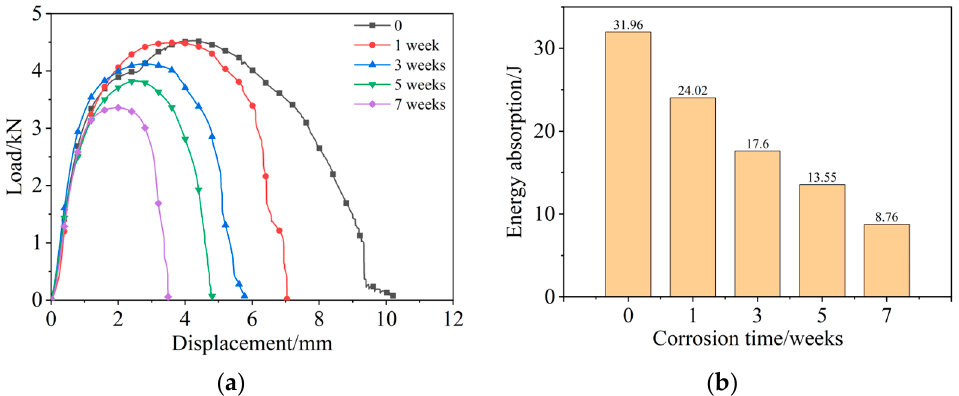
Figure 5. Load-displacement curves ( a ) and energy absorption values ( b ) of joints under different corrosion durations.